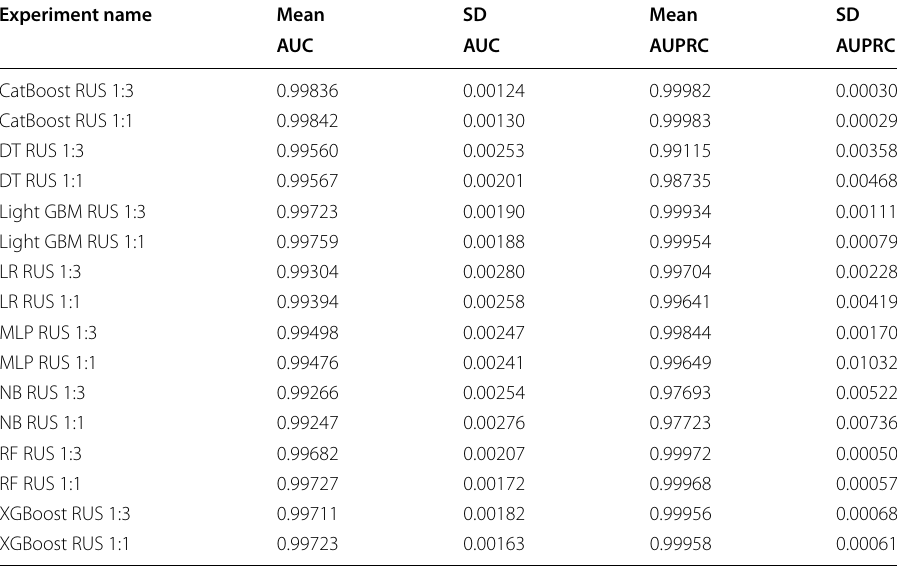
Table 3 Classification results for the information theft dataset with sampling and default hyperparameters experiments; mean and standard deviations of AUC and AUPRC, (10 iterations of 5-fold cross-validation)